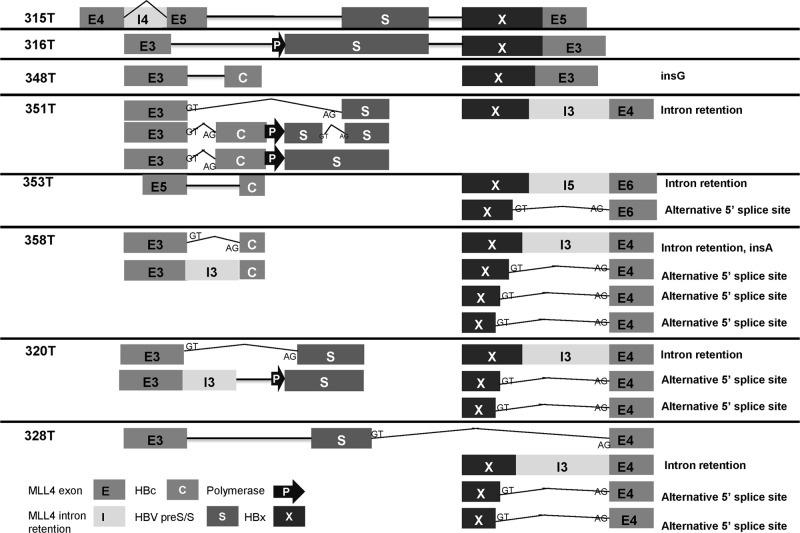
cDNA structure of HBV integration.Cartoon illustrating HBV-integrated cDNA structures. Full-length (315T, 316T, and 328T) and partially inserted cDNA sequences are shown for each sample, noted with alternative splicing isoforms for each transcript.